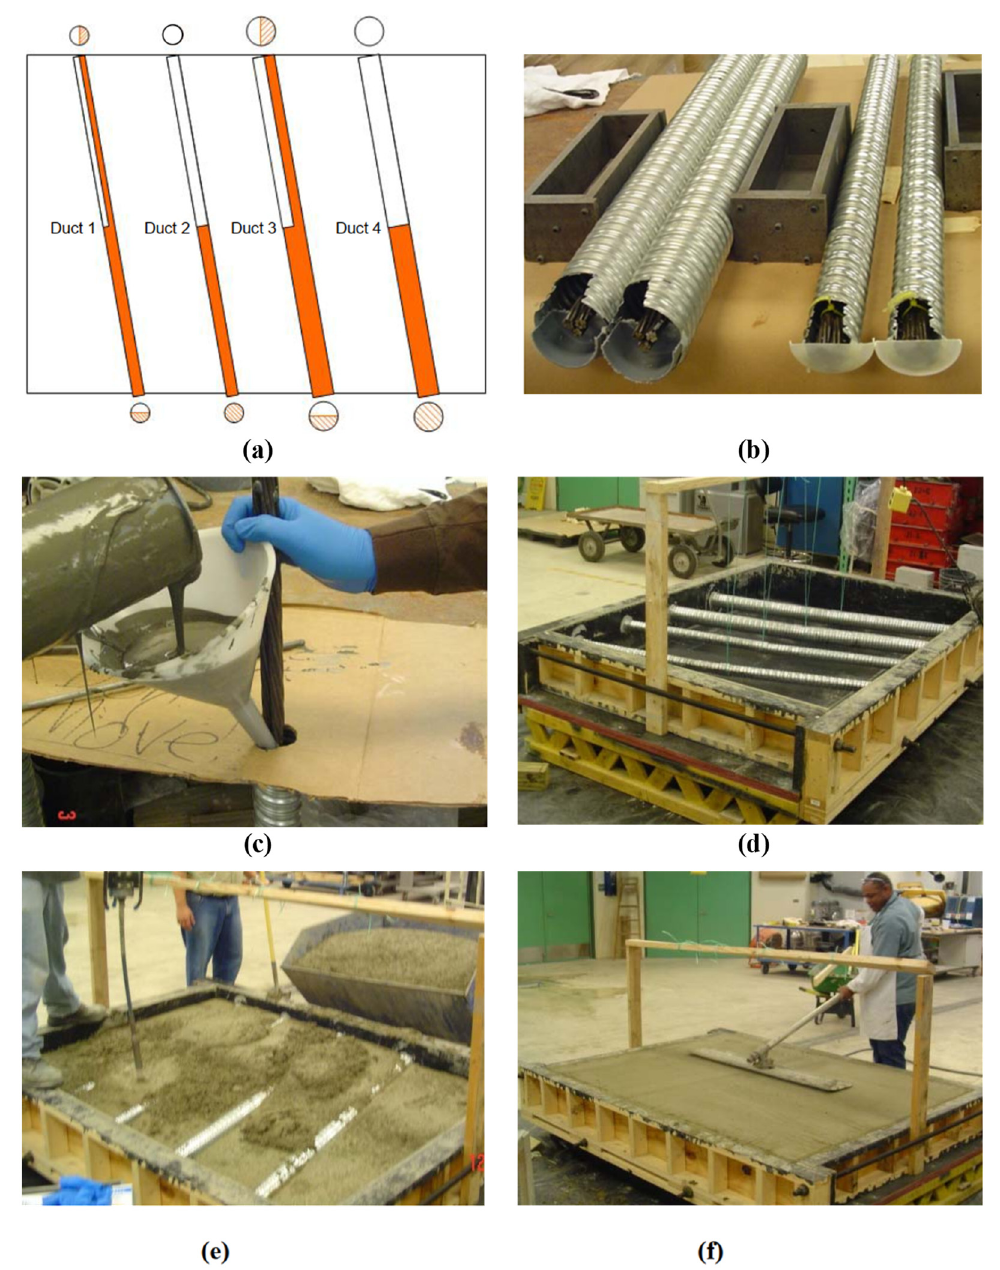
Figure 14. Slab 7: ( a ) schematic design, ( b ) preparing duct, ( c ) fi lling the grout, ( d ) installing the ducts in formwork, ( e ) concrete placement, ( f ) fi nishing the concrete surface [46]. As to the fi rst of the three items in the aforementioned list, one can observe a clear segmentation of duct 2 in both Figure 15a,b where the fully grouted section of the duct appears to be further away from the scanning surface than the empty section. This can be a tt ributed to the re fl ection from the lower boundary of the duct, which was enabled by the presence of the grout. Based on the design of the slab, the same should be expected for duct 4. However, as indicated in the images obtained from both datasets (Figure 15a,b), such a shift only occurs for a segment of the “so-designed” fully grouted section. That said, it is very likely that the desired bonding in that section has been lost partially along